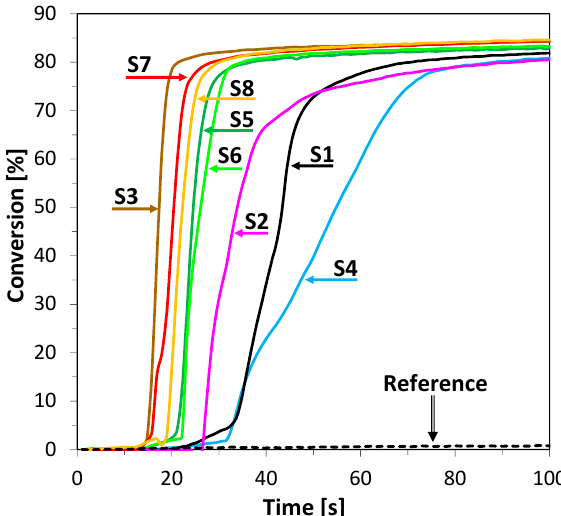
Figure 5. Polymerization profiles of tri(ethylene glycol) divinyl ether (TEGDVE) (vinyl function conversion vs. irradiation time) upon exposure to the UV LED at 365 nm (intensity at the surface of sample 1.59 mW/cm 2 ) under laminate in the presence of different photoinitiating systems based on diphenyliodonium salt (HIP, 1 wt.%) and 2-amino-4,6-diphenyl-pyridine-3-carbonitrile derivatives (0.1 wt.%). The irradiation starts at t = 10